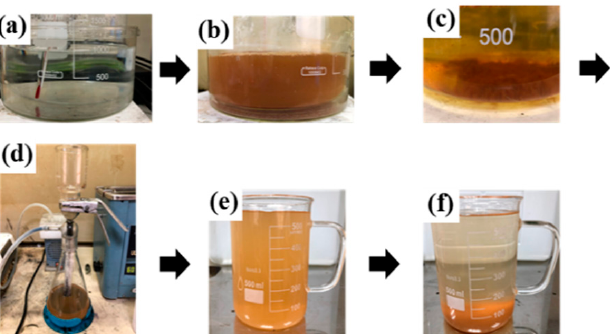
Figure 4. Process of plasma polishing process: ( a ) unpolished, the color is transparent; ( b ) during polishing; ( c ) after polishing, precipitation for 5 min; ( d ) suction filtration of the polishing liquid; ( e ) collection of polishing liquid after suction filtration; ( f ) precipitation of filtrated polish.